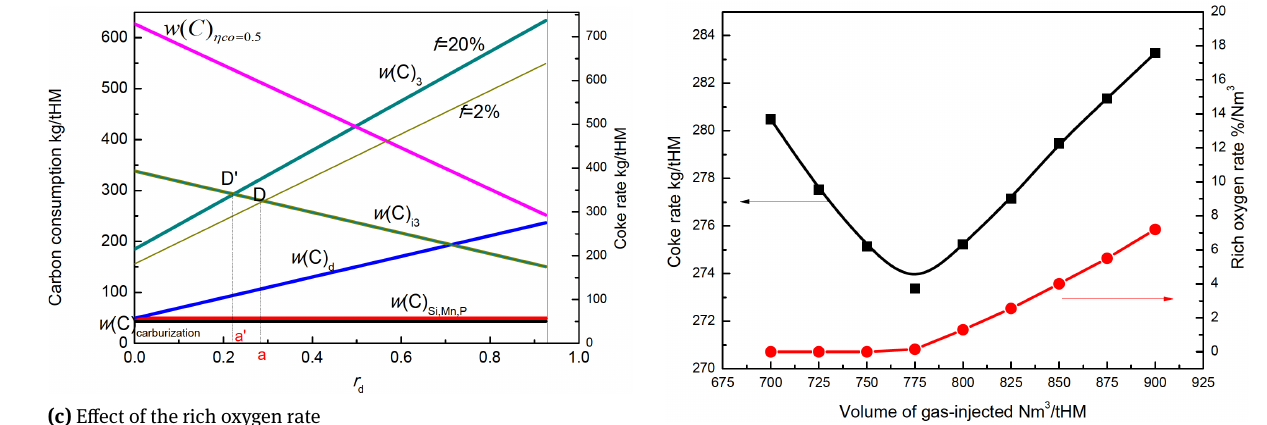
Figure 4: Effect of operation parameters on energy consumption in the gas-injection BF